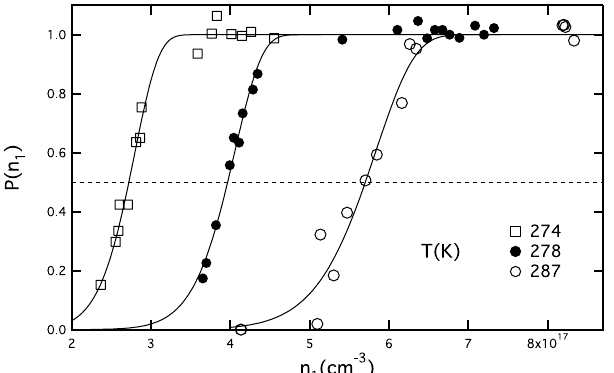
. Largest shift occurs at the 1